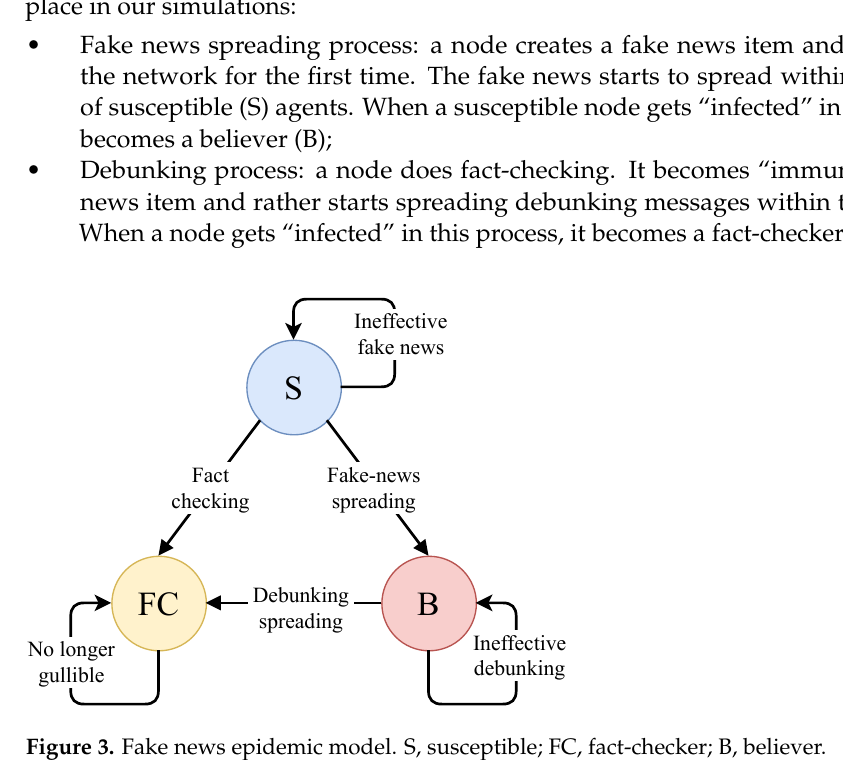
Figure 3. Fake news epidemic model. S, susceptible; FC, fact-checker; B,